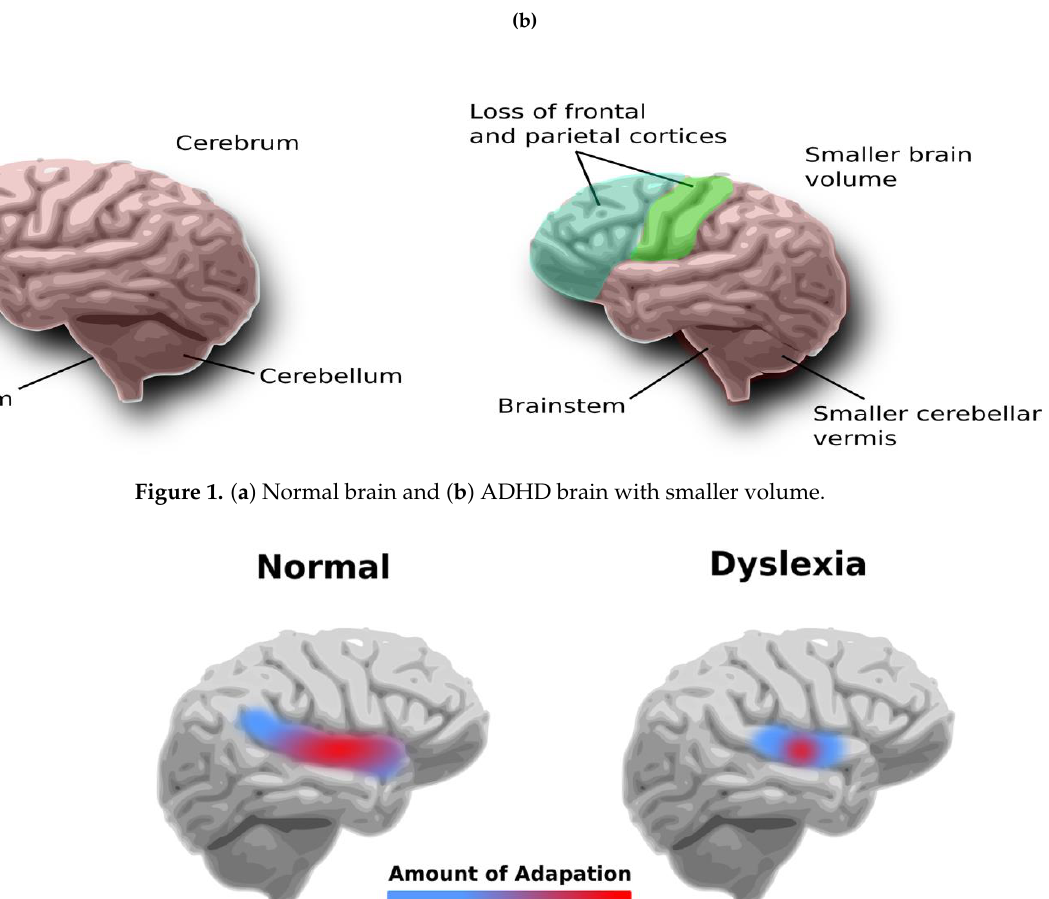
Figure 1. ( a ) Normal brain and ( b ) ADHD brain with smaller volume.